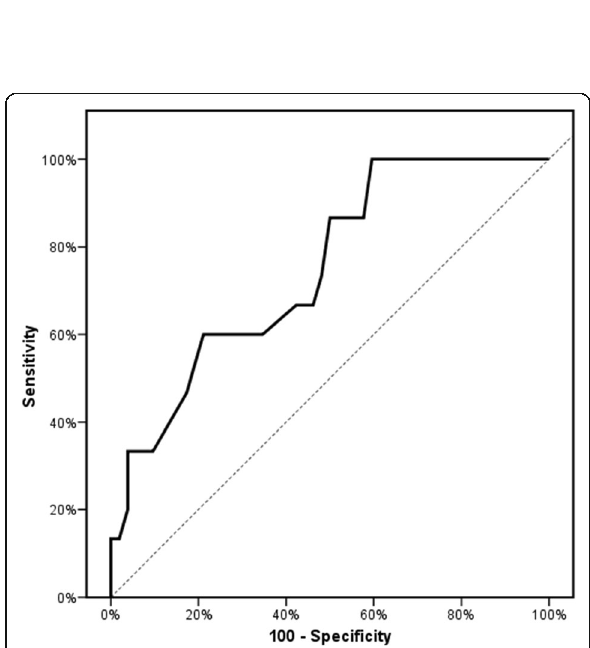
Fig. 7 ROC curve to assess agreement (sensitivity, specificity) of the ADC ratio to diagnose cases with papillary RCC from other masses. Cutoff ADC ratio of ≤ 0.56 ADC to diagnose cases with papillary RCC from other masses can be used with a sensitivity of 88.67% and specificity of